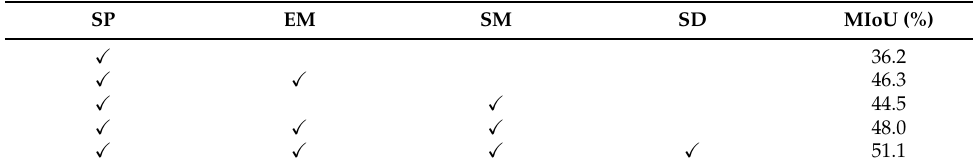
Table 3. Ablation study on GTA5 → cityscapes task.